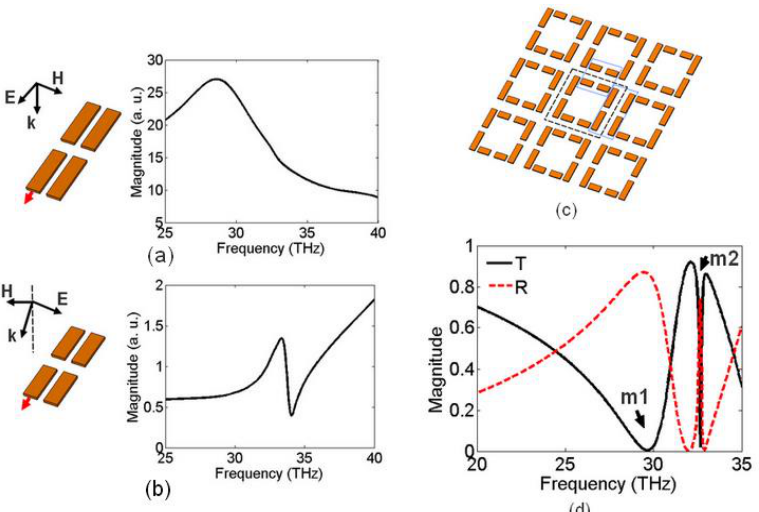
Figure 1. ( a ) A pair of two parallel metallic stripes under a normal incidence (left) and the spectral response of an electric probe (red arrow) placed near from the center of the end facet of one metallic stripe (right). ( b ) A pair of two parallel metallic stripes under an oblique incidence (left) and the spectral response of an electric probe indicated by a red arrow (right). ( c ) Schematic view of the metamaterial composed of an array of 8-gap split ring resonators (SRRs). ( d ) Transmission and reflection spectra of the 8-gap